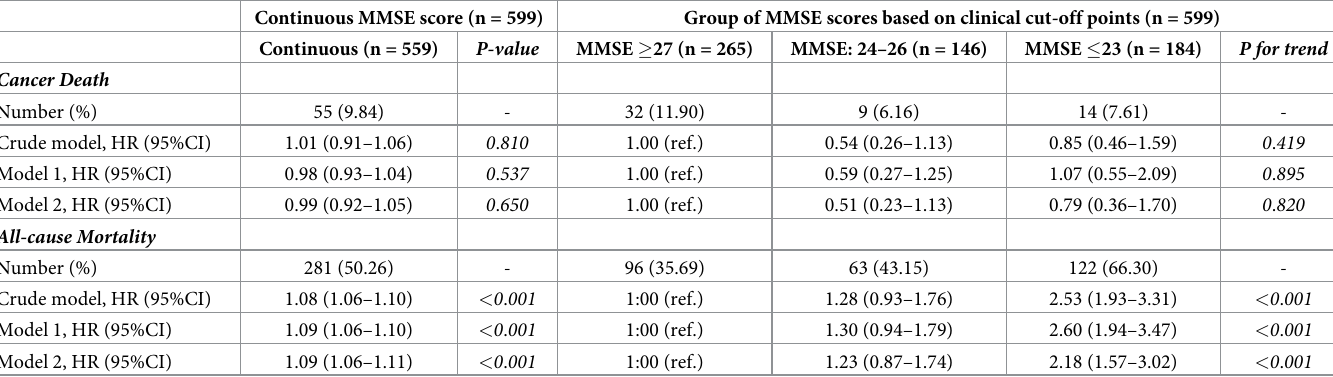
Table 4. Risk of cancer death and all-cause mortality depending on MMSE scores of Leiden 85-plus study.